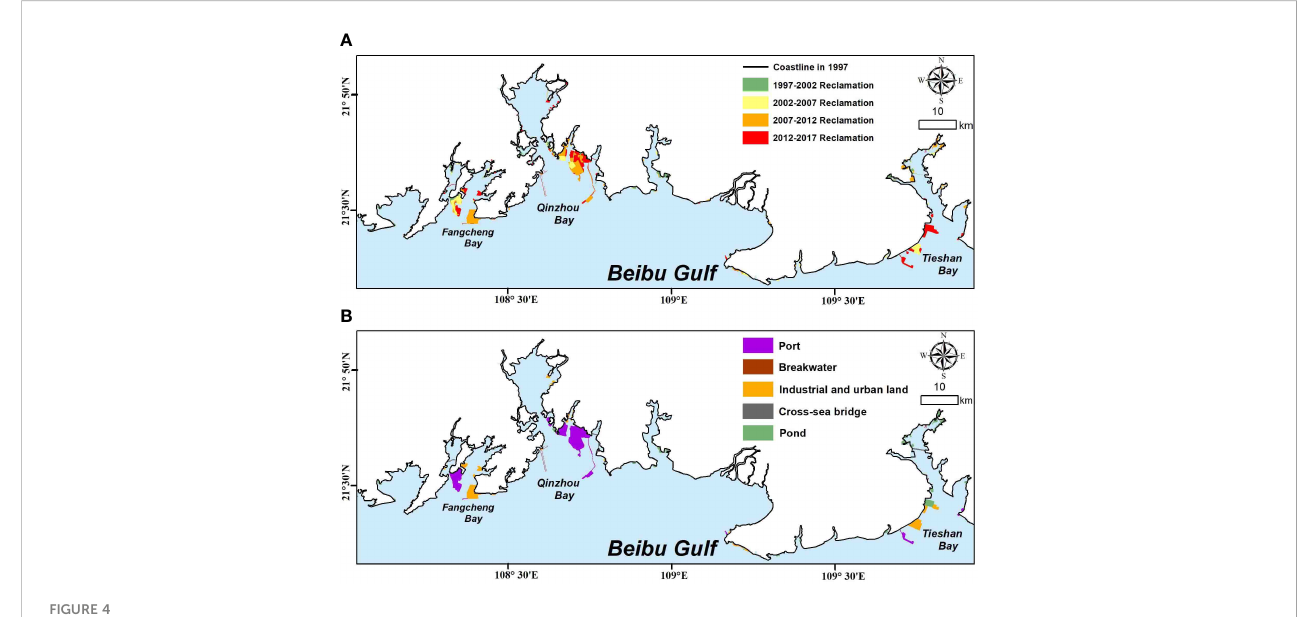
FIGURE 4 Spatio-temporal change of reclamation and its use